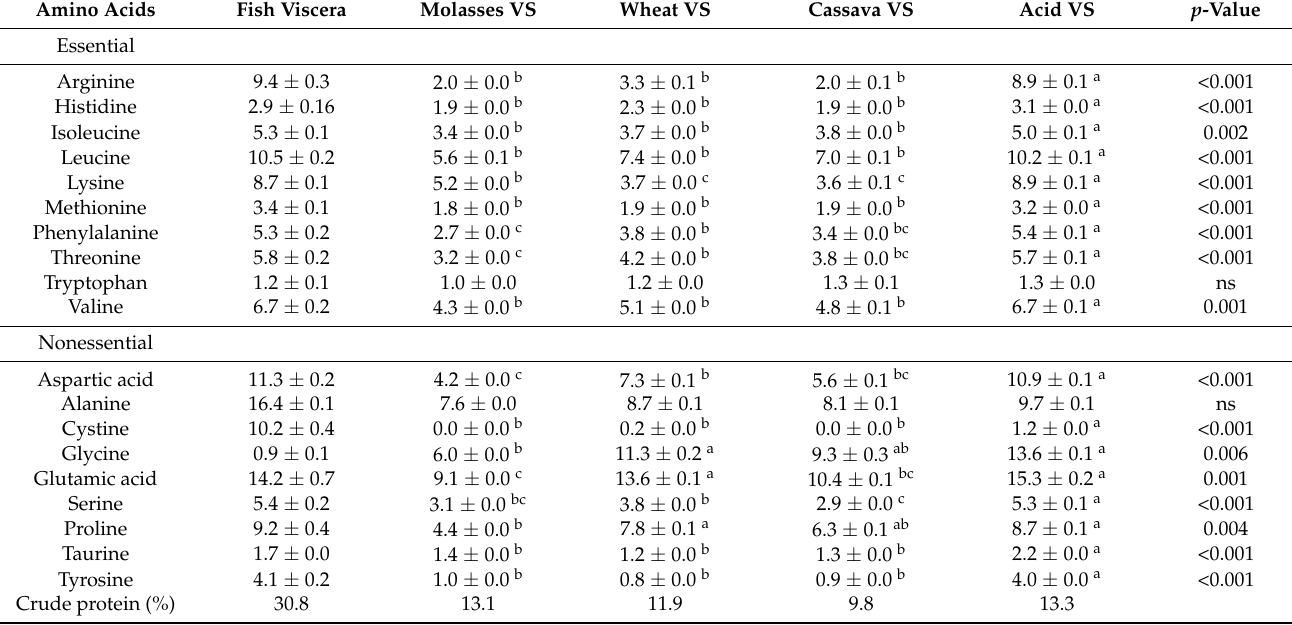
Table 3. Amino acids of fish viscera and viscera silages after 7 days of storage (mg · g − 1 crude protein).